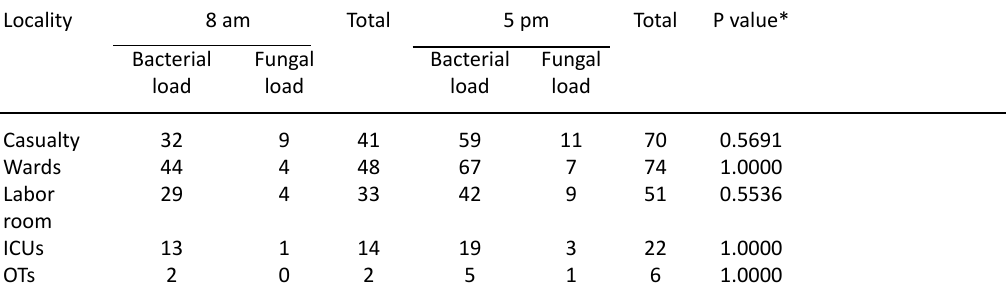
isolates were identified during 8 am and 192 bacterial and 31fungal isolates were identified at 5 pm sampling. In this study, the microbial contamination was found higher in wards (122 isolates) and low in operation theatres (8 isolates) which is shown in Table 2. Different microbial flora were found contaminating indoor air, which range from higher prevalence of Staphylococcus aureus (27.72%) followed by Diptheroids (24.75%), Table 2. Airborne microbial contamination from different places of the hospital Locality 8 am Total 5 pm